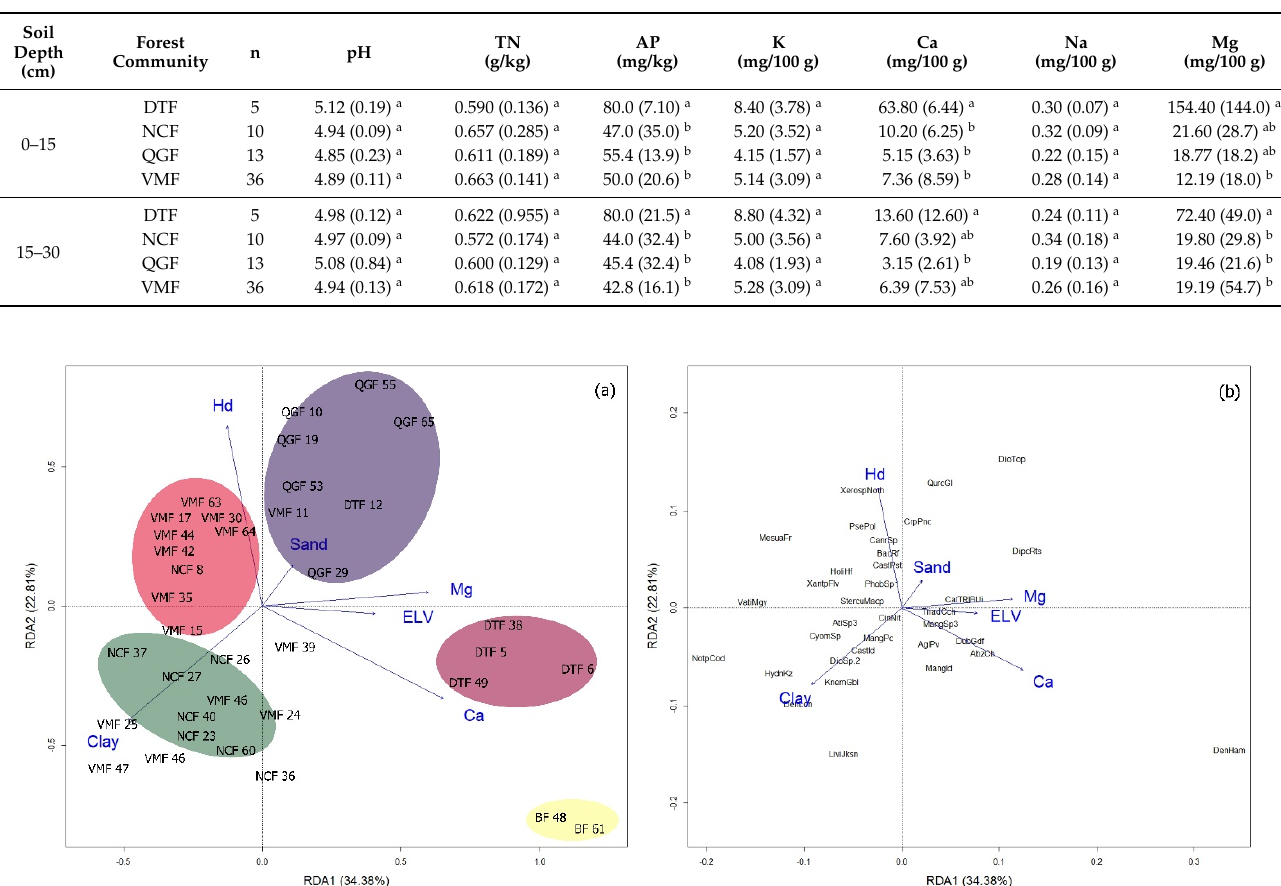
Figure 2. Redundancy analysis (RDA) biplot showing the ( a ) relationship among environmental variables and forest communities and ( b ) relationship among environmental variables and dominant tree species at 0–15 cm soil depth in Htamanthi Wildlife Sanctuary. Abbreviations: ELV—elevation, Hd—soil hardness, Mg—extractable magnesium, Ca—extractable calcium; forest communities: Vatica maingayi forest (VMF), Quercus glauca forest (QGF), Nothaphoebe condensa forest (NCF), and Diospyros toposia forest (DTF). The number after the abbreviated name of the forest community in panel ( a ) indicates the plot number. In panel ( b ), the black lowercase letters indicate the abbreviated scientific names of dominant tree species (Table S1).